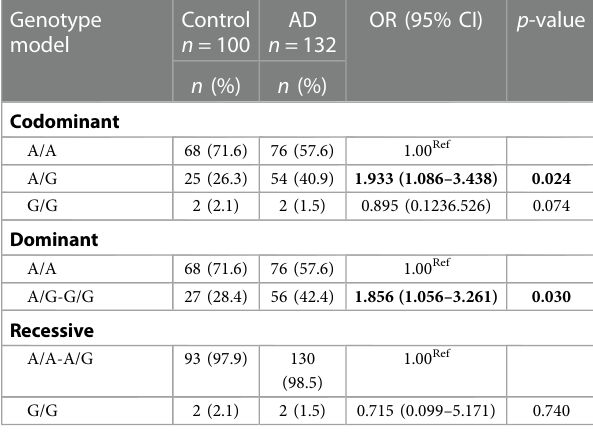
TABLE 4 Genotype model analysis of IL-6 rs2069837 in AD cases and controls. Genotype model